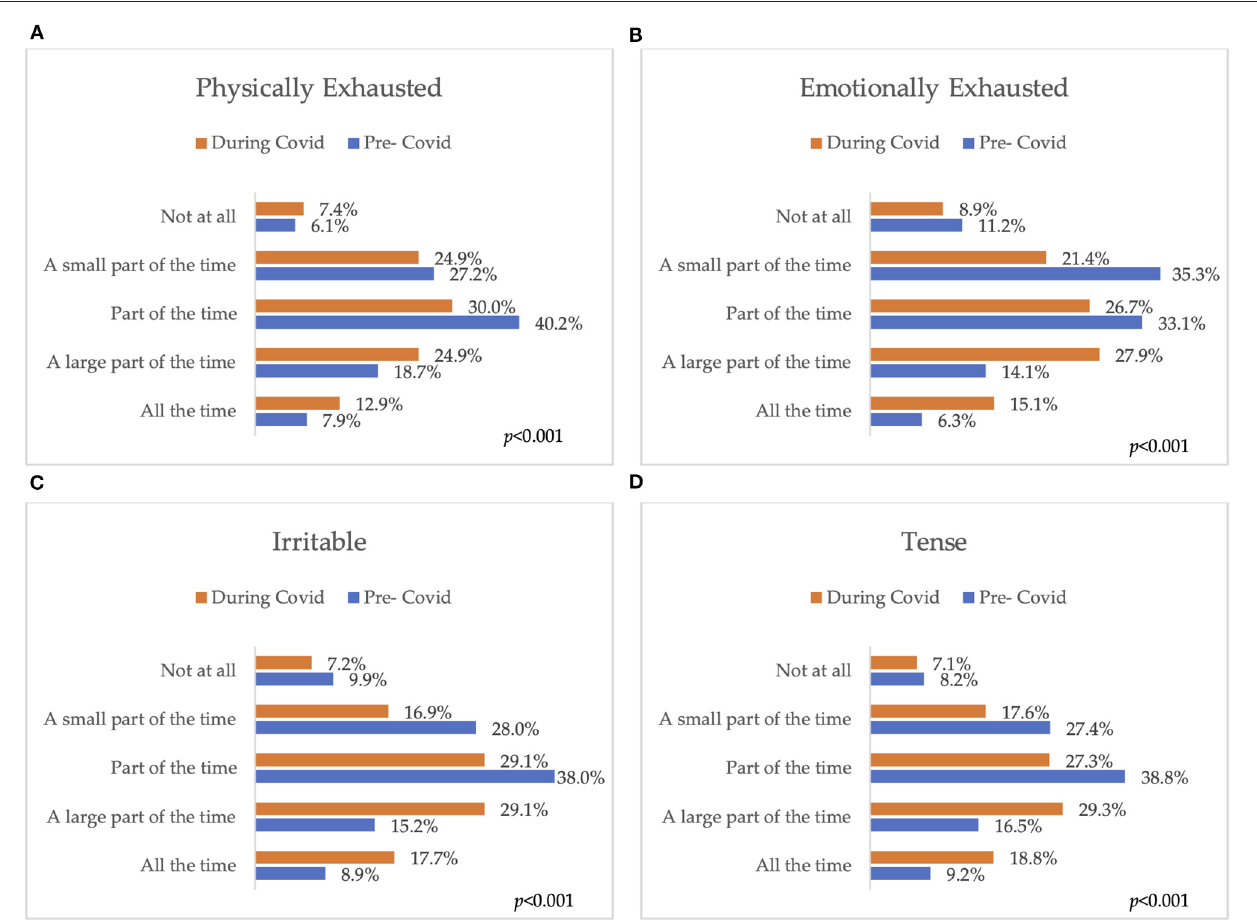
FIGURE 2 | Stress and irritability pre-and during the COVID-19 pandemic (A) Physical exhaustion; (B) Emotional exhaustion; (C) Irritability; (D) Tension. The p values indicate the statistical significance of the McNemar